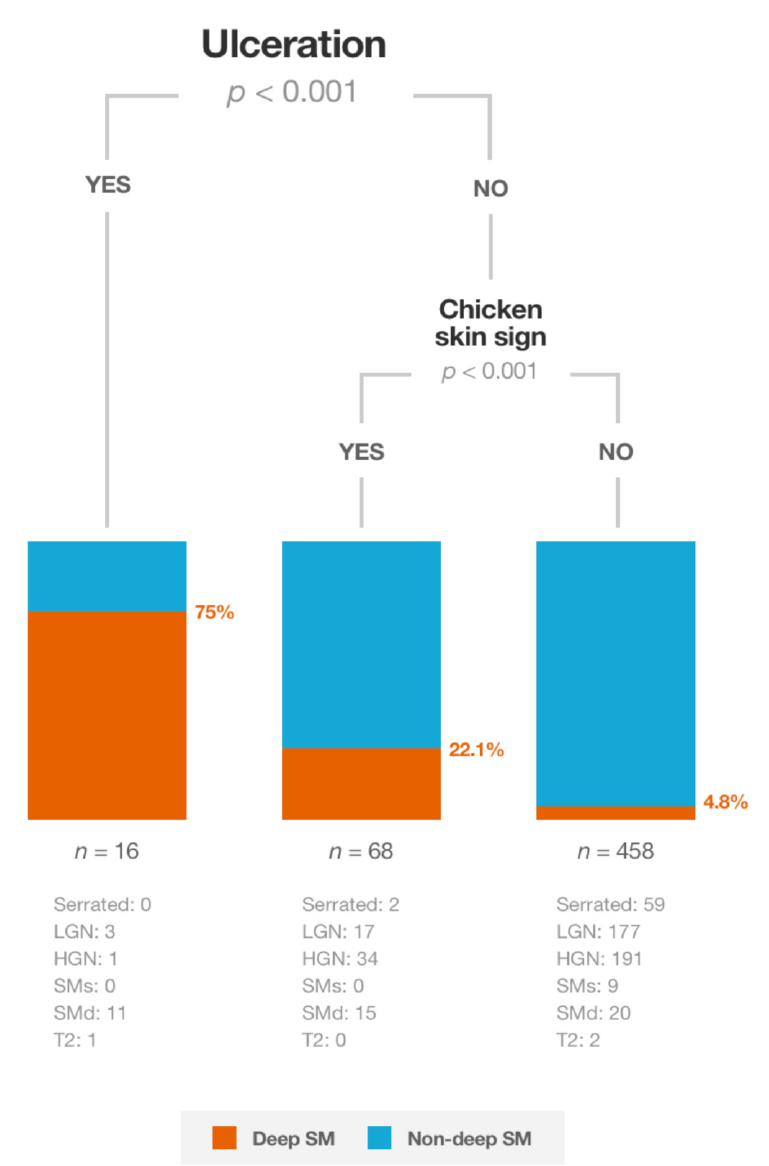
Figure 2. Conditional inference tree for predicting deep submucosal